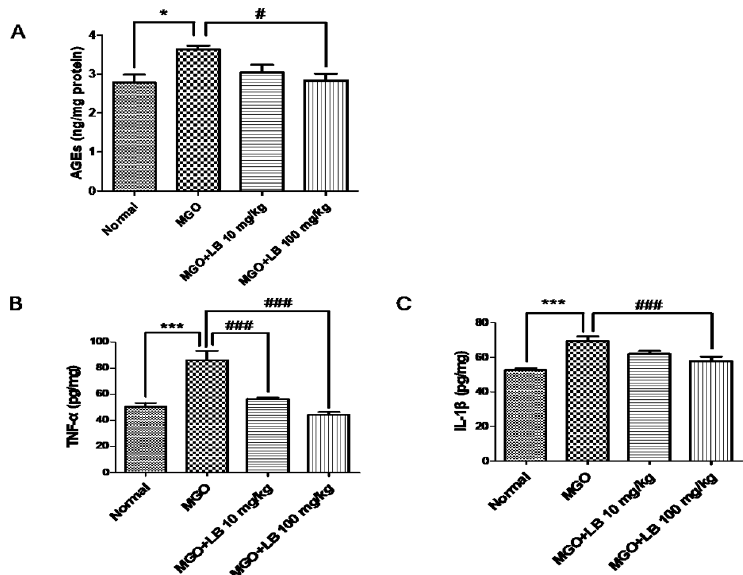
Figure 5. The effect of LB on MGO-induced elevation in the levels of AGEs and proinflammatory cytokines in the kidneys of MGO-treated mice. ( A ) Total amount of AGEs. ( B ) Levels of TNF- α . ( C ) Levels of IL-1 β . The levels of AGEs and cytokines were determined by ELISA (ng/mg of protein). The bar values represent the mean ± SEM (# p < 0.05, ### p < 0.001 vs. MGO treatment, and * p < 0.05, *** p < 0.001 vs. the control, n = 6).